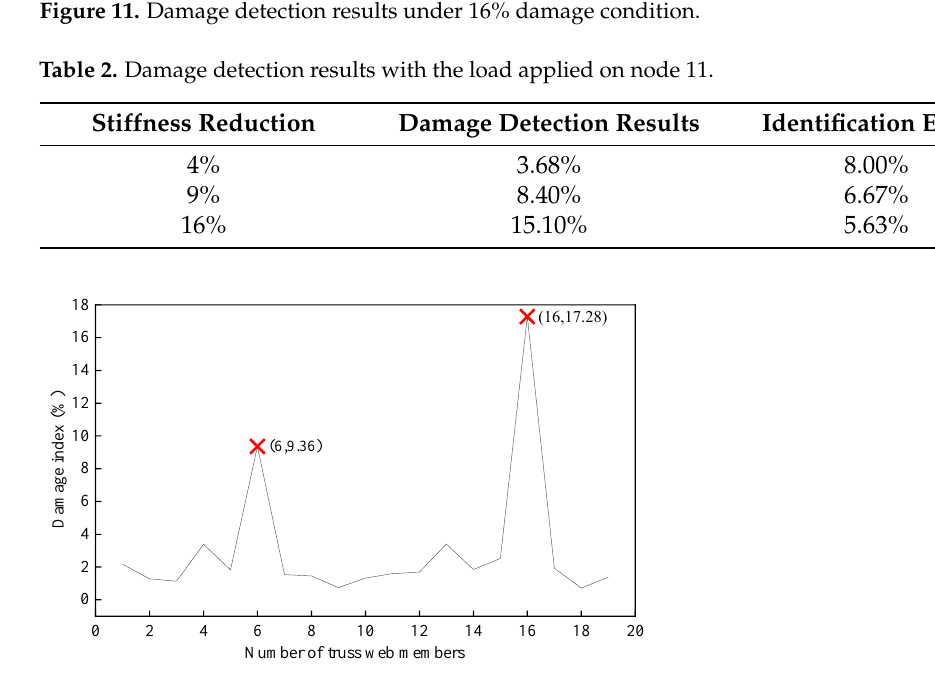
Figure 11. Damage detection results under 16% damage condition.